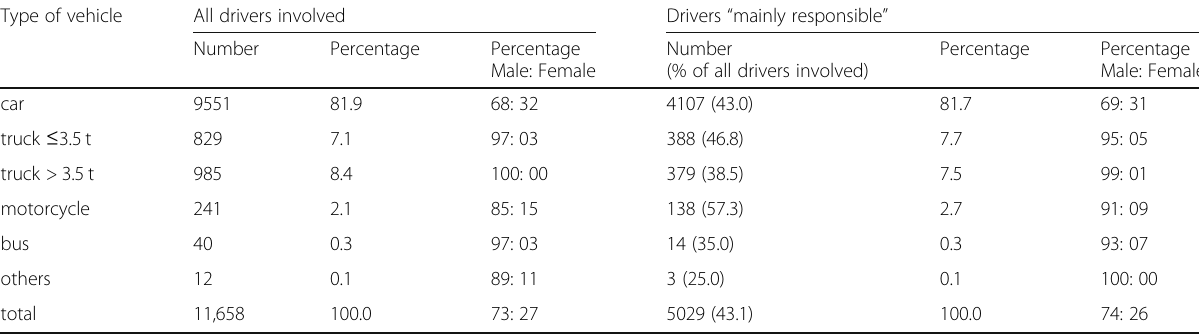
Table 2 Vehicle drivers involved and drivers “ mainly responsible ” for the crash Type of